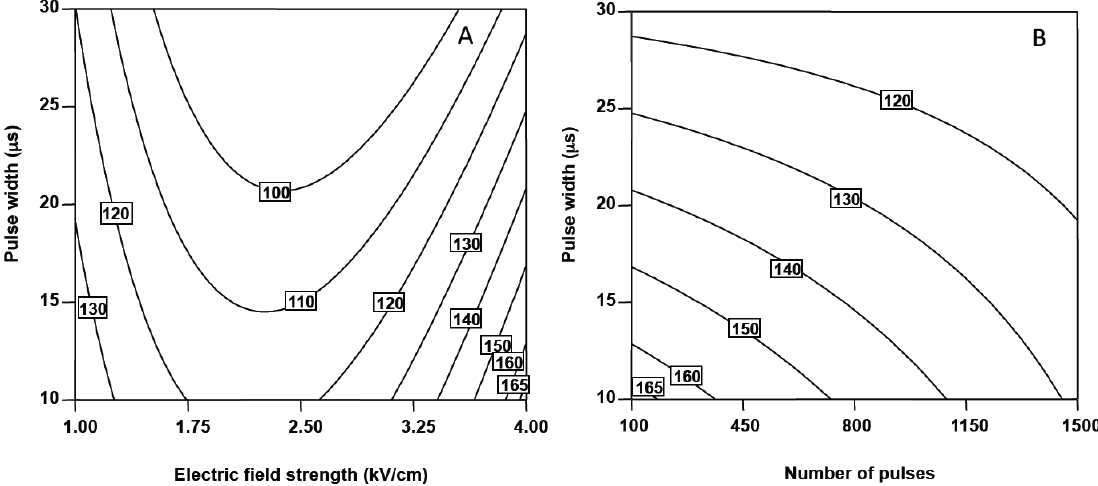
Figure 3. Counter plots for the combined effect of pulse width and electric field strength ( A ) and pulse width and number of pulses ( B ) on FaDOAc relative content of carrot slices. (A) Pulse frequency set at 10 Hz and number of pulses set at 100. (B) Pulse frequency set at 10 Hz and electric field strength set at 4